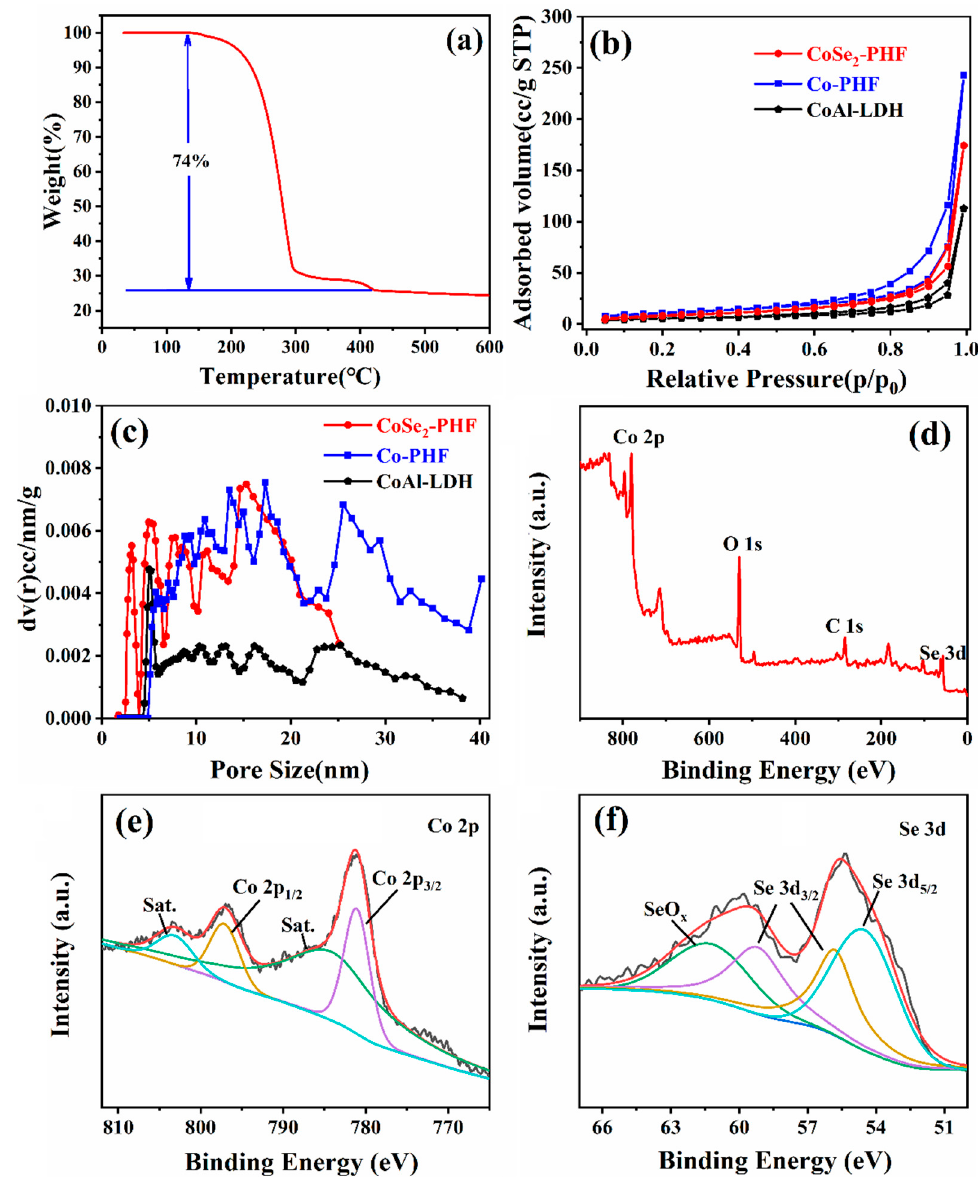
Figure 3. ( a ) TGA curve of CoSe 2 -PHF/S, ( b ) N 2 adsorption and desorption isotherms, ( c ) The pore-size distribution plots,